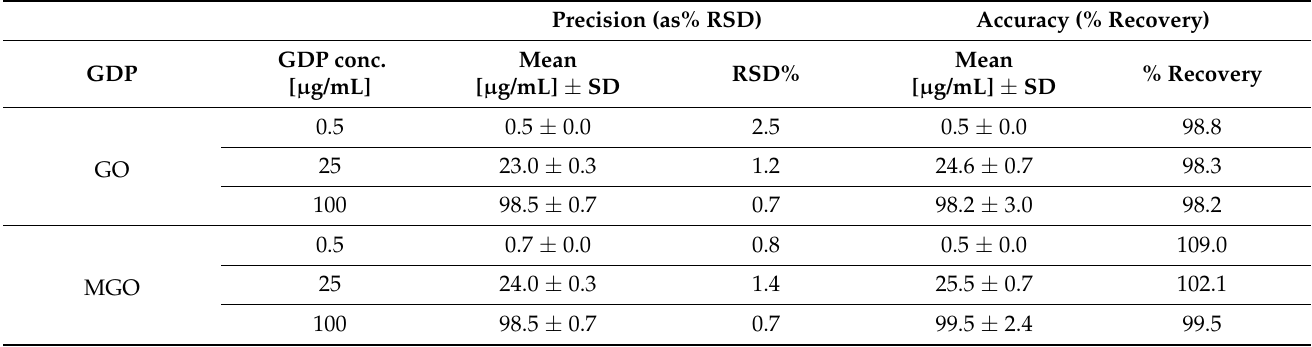
Table 11. Precision in terms of % relative standard deviation (RSD) for replicate measurements ( n = 3) at three different levels, and accuracy reported as percent recovery for three concentrations/six replicates each of the total analytical